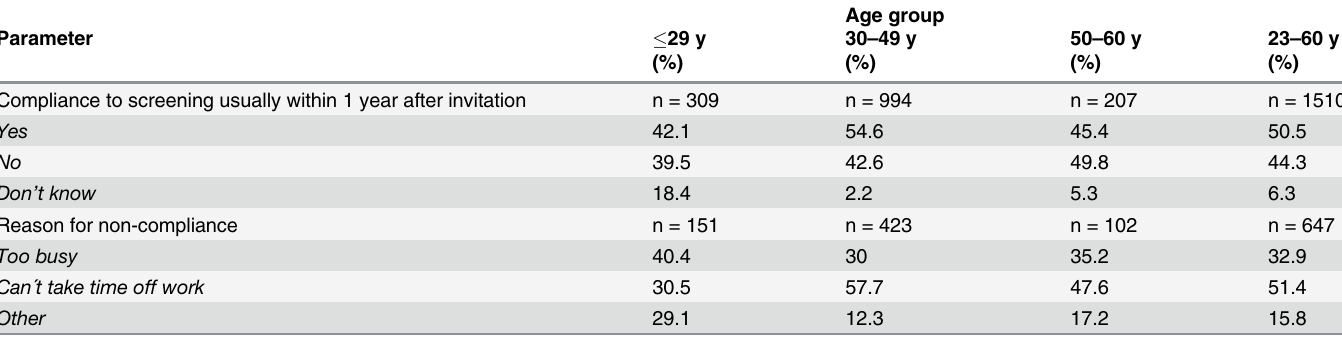
Table 5. Screening compliance for 1510 women attending the clinic-based cervical cancer screening program in